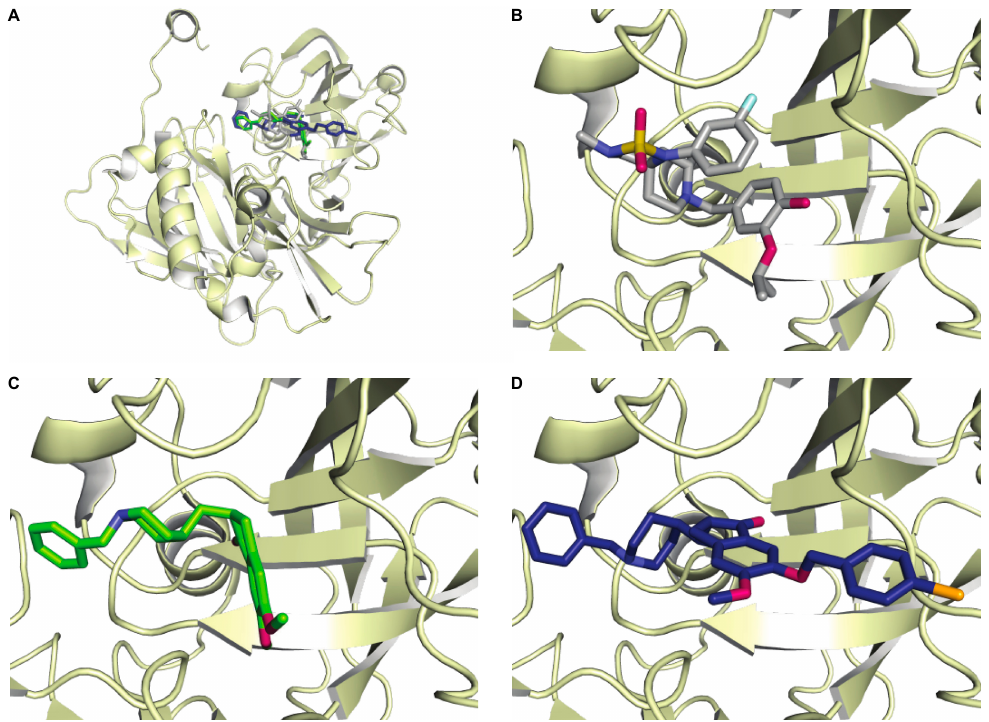
Figure 1. Molecular docking showing the overlay of donepezil (green) and compound 8l (navy blue) with the known BACE1 inhibitor (gray) crystallized with BACE1 (PDB# 4FM7 [25]), shown as ribbons. Panel A shows the three compounds in the active site of BACE1. Panels B – D show the zoomed-in view of the known inhibitor ( B ), donepezil ( C ), and compound 8l ( D ).